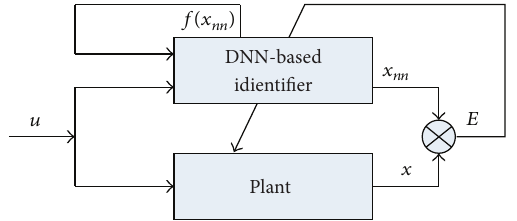
Figure 2: The architecture of system identification based on DNN.